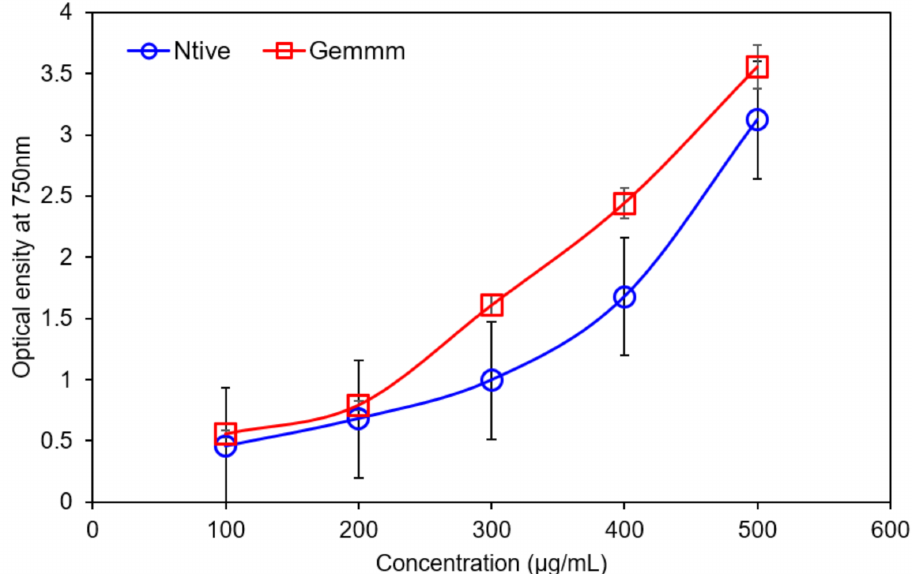
Figure 4. Total Phenolic Contents of Native and gemm extracts of H. griffithi .